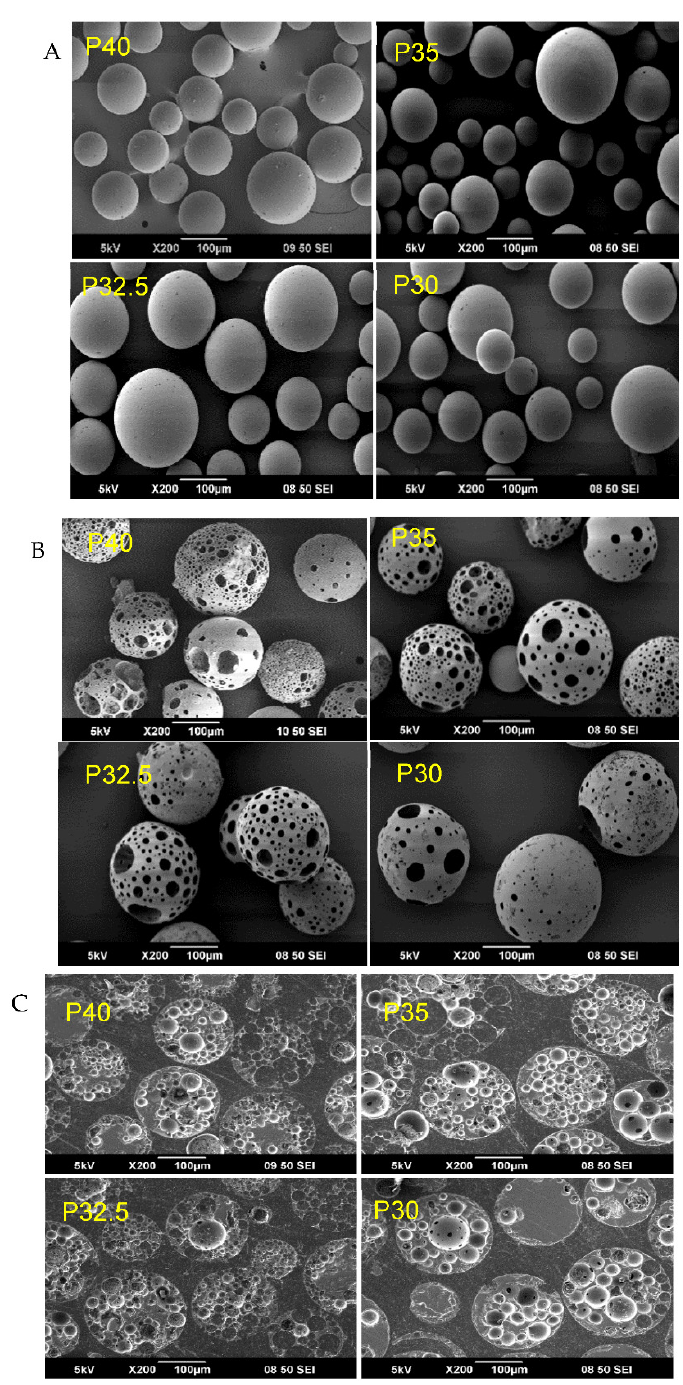
Figure 1. ( A ) SEM images of P40, P35, P32.5 and P30 solid microspheres, ( B ) SEM images of P40, P35, P32.5 and P30 porous microspheres and ( C ) SEM images of resin embedded P40, P35, P32.5 and P30 porous microspheres revealing their cross-section and showing the interconnected porosity.